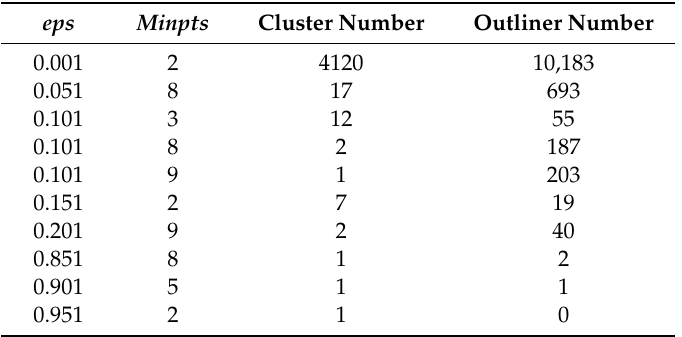
Table 1. The number of clusters and outliers under di ff erent